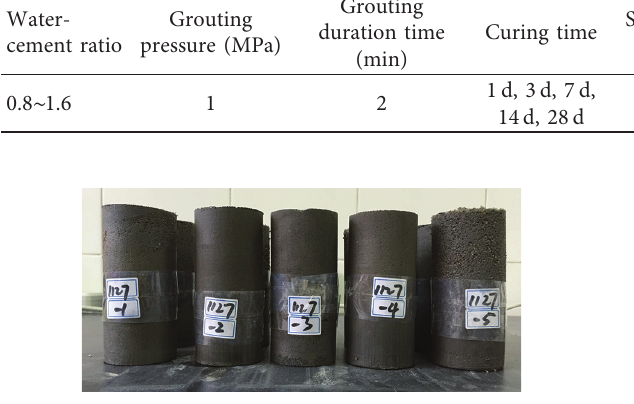
Figure 4: Demolded grouted